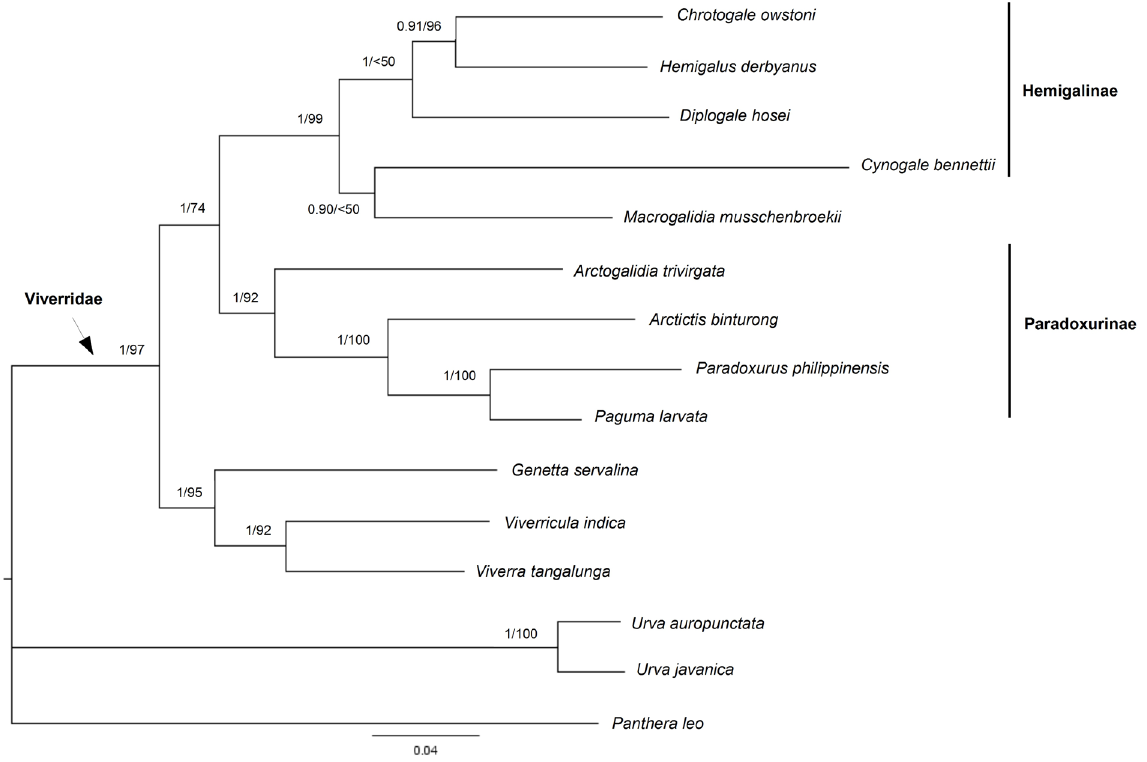
Fig. 2. Bayesian tree reconstructed from a combined dataset of Cytb + ND2 + FGB + IRBP (3342 bp). The values on the branches are bayesian posterior probabilities for the partitioned analysis (see text for models) and bootstrap proportions obtained from ML analysis (model: GTR + I +